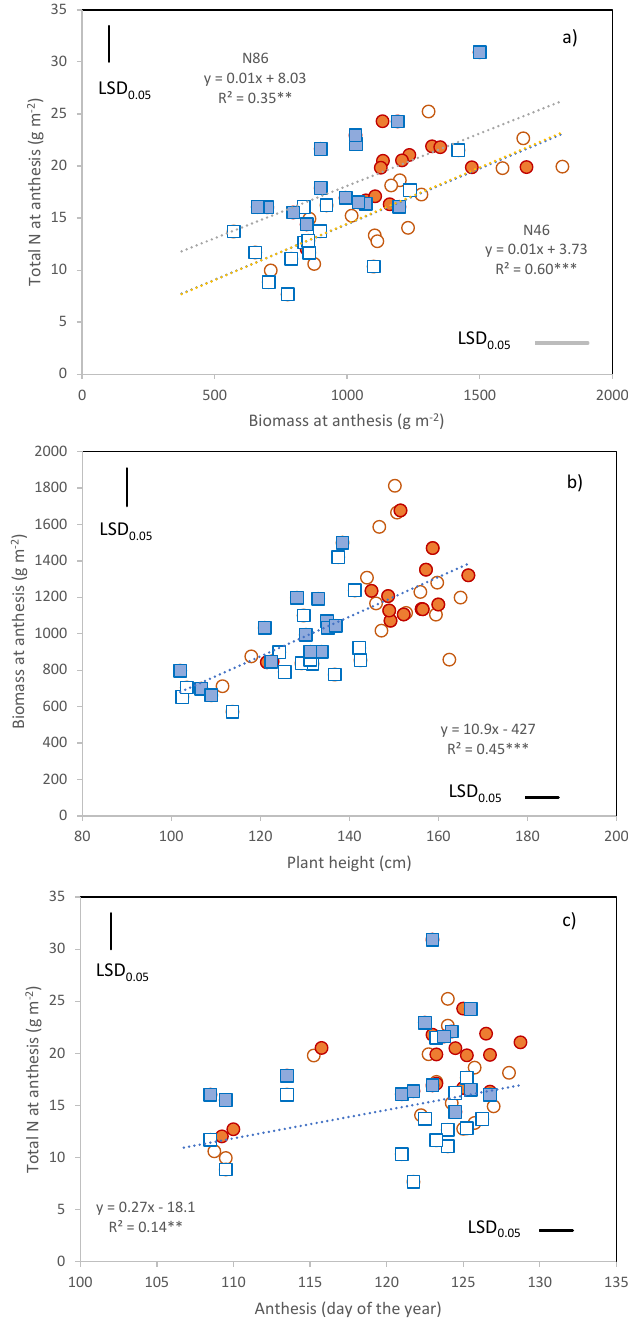
Figure 2. Anthesis sampling. Relationships between ( a ) Total N and biomass; ( b ) Biomass and plant height; ( c ) Total N and anthesis date. Data are C × Y × N means: orange circles, 2016; blue squares 2017; empty symbols, N46; filled symbols, N86. Separate regressions were calculated for the two N treatments in ( a ). LSD 0.05 for the comparison of cultivar means within each Year × N combination. **, Pearson correlation coefficient significant at p ≤ 0.01; ***, Pearson correlation coefficient significant at p ≤ 0.001.